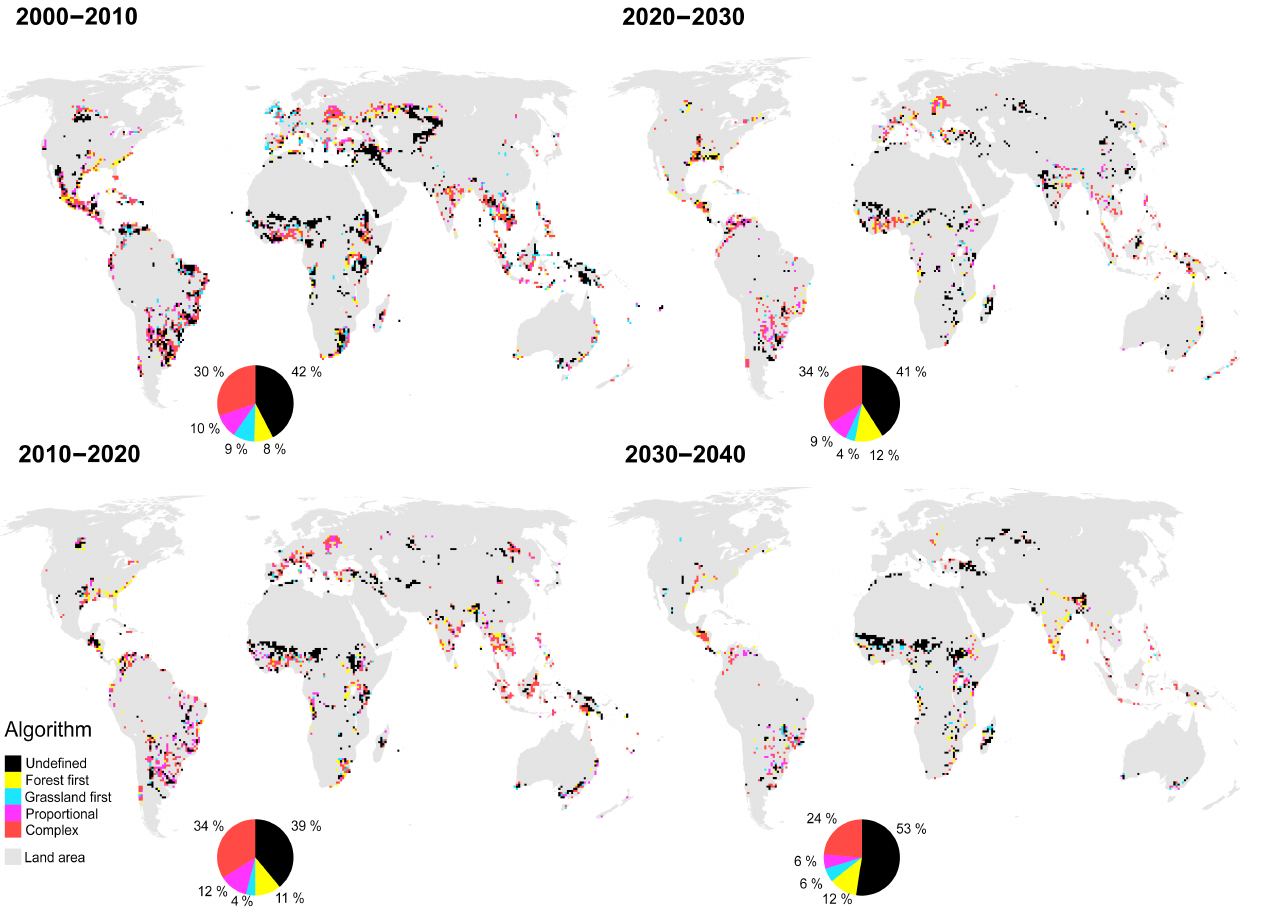
Figure 5. Transitions from natural vegetation to cropland as shown by the CLUMondo model (FAO 3 demand scenario) from 2000 to 2040 in decadal time steps. Colored grid cells represent areas with at least 10% of cropland expansion within a ca. 0.5 ◦ × 0.5 ◦ grid cell. Grid cells are classified according to forest-first (yellow), grassland-first (cyan), proportional (magenta), and complex (red) reduction algorithms as described in the text (for details see Supplement Sect. S2.4). Black grid cells denote areas where the validity of no algorithms could be detected. Grid cells classified as unvegetated first (Table 3) are not shown due to a very small contribution (<0.1%). Grid cells in this figure have been aggregated to ca. 1.0 ◦ × 1.0 ◦ following a majority resampling for reasons of readability. A high-resolution version of the maps, including the full detail of the classification results, can be found in the Supplement (Fig.